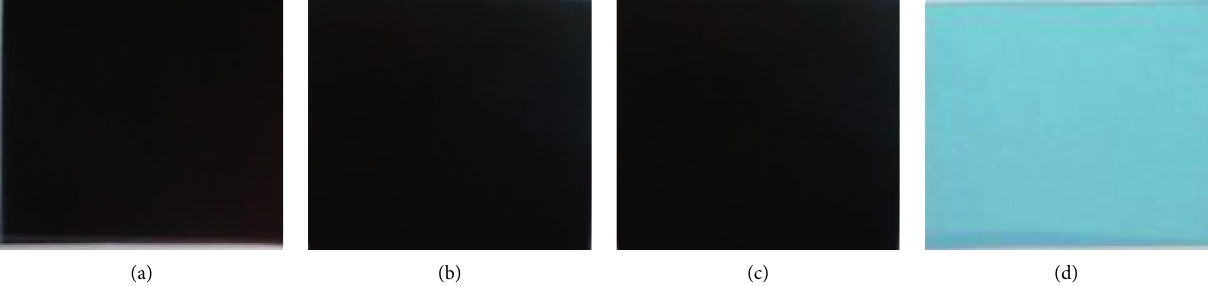
Figure 2: Removal of gelatin and recovery of silver from X-ray films from crude bromelain. Used X-ray films (a) and (b) were collected from Dessie Referral Hospital and (c) and (d) were collected from other health centers that have not used digital X-ray processing machines. Used X-ray films, (a) and (c), were control treated with phosphate buffer only, whereas (b) and (d) were enzyme (20 ml � 144U) treated